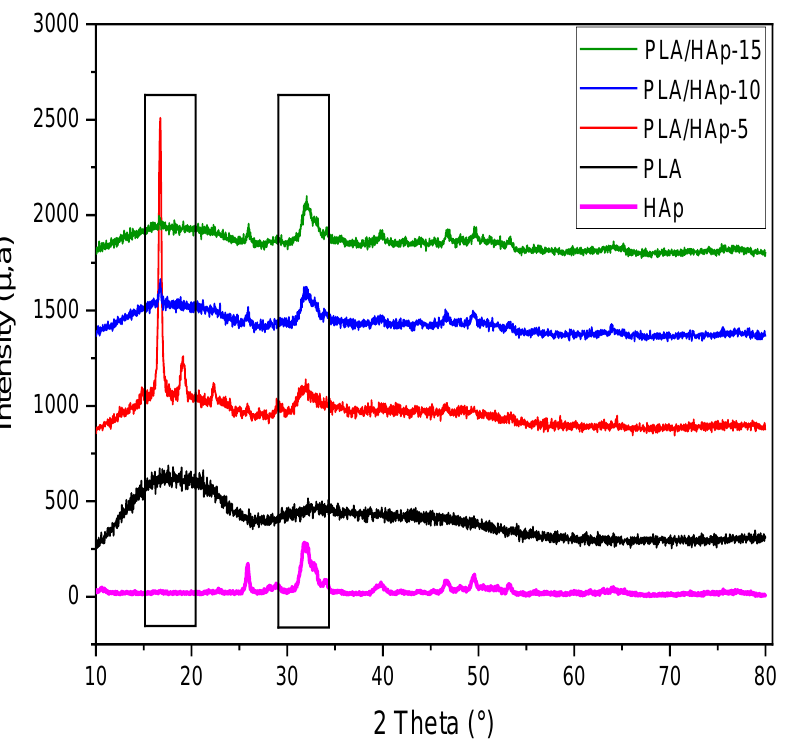
Figure 8. XRD patterns of HAp, PLA and PLA/HAp composites at various filler content ratios, i.e., 5, 10 and 15 wt%.